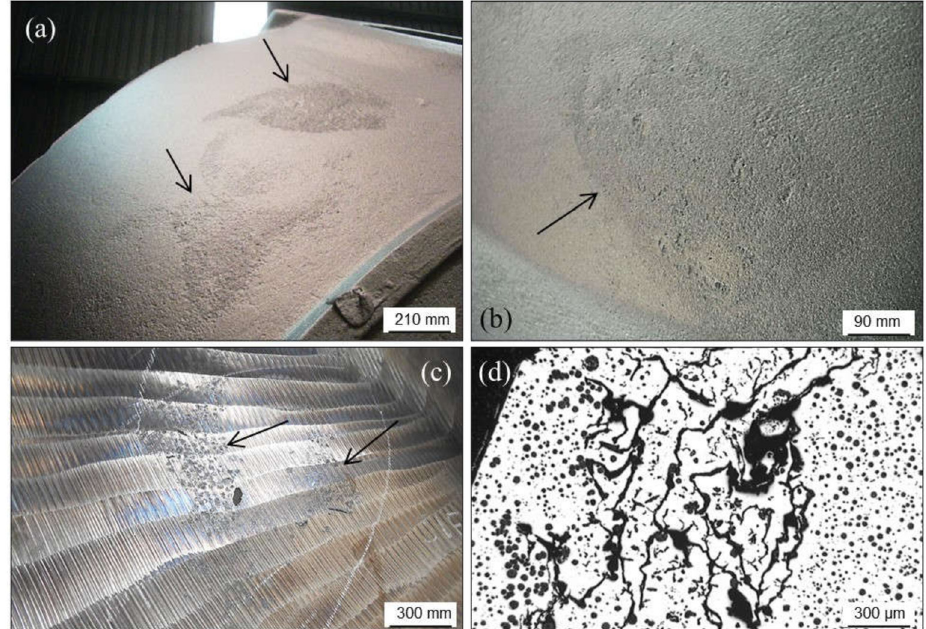
Figure 35. Dross inclusions in heavy-section ductile iron castings ( a – c ); metallographic view of a dross inclusion in the same castings ( d